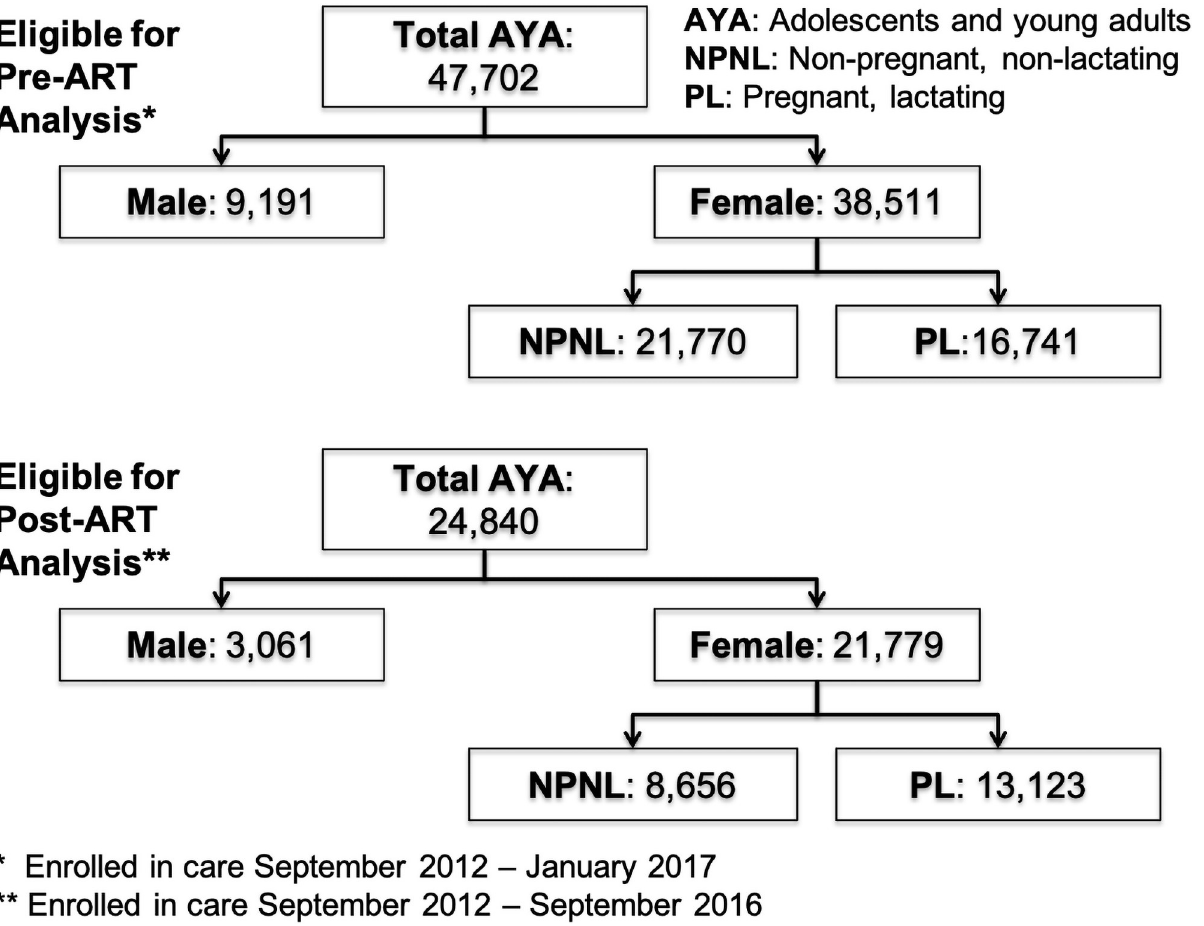
Fig 1. Flow diagram of eligibility for pre- and post- antiretroviral viral therapy analysis.